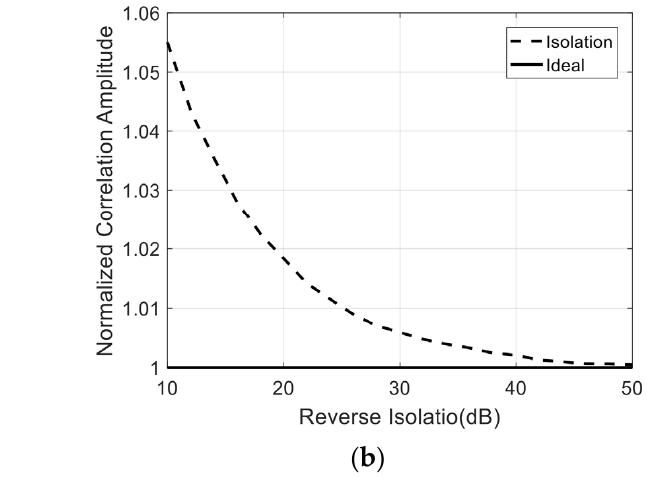
Figure 3. Influence of mismatch of the detection circuit on correlation results: ( a ) The variation of the correlation circle with the reverse isolation; ( b ) The variation of the radius of the correlation circle with the reverse isolation.